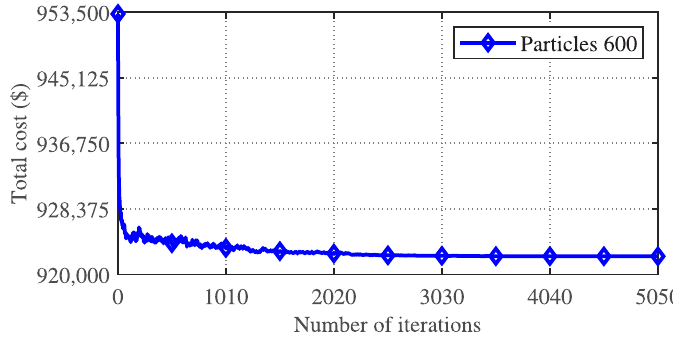
Fig 1. Convergence characteristics of APSO variant-16 for the CSTHTS